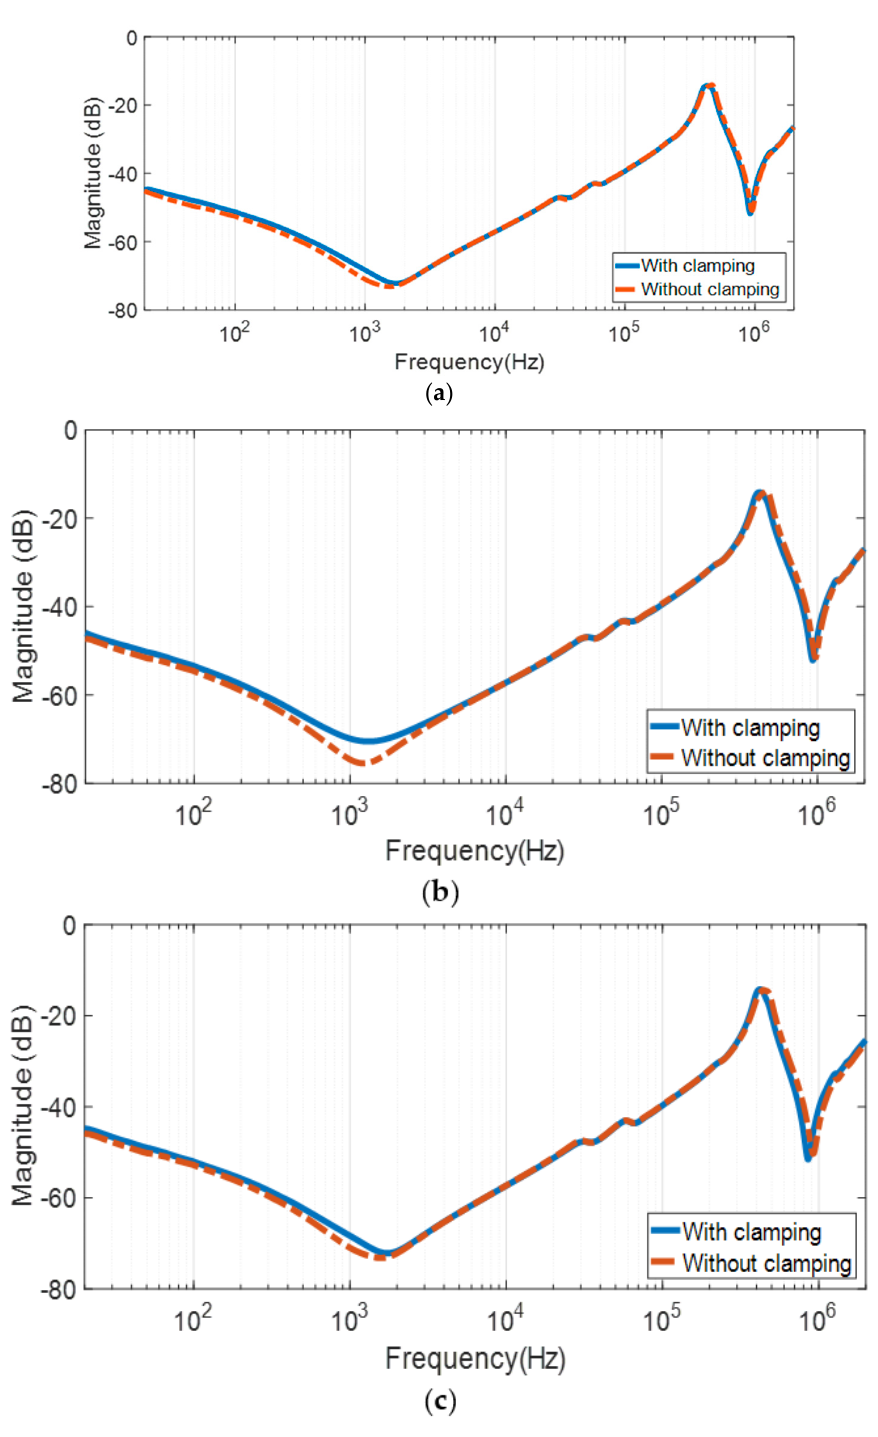
Figure 3 Figure 3. End-to-end open circuit test on HV winding. Measurement at terminals: ( a ) R-Y for phase R; ( b ) Y-B for phase Y; ( c ) B-R for phase